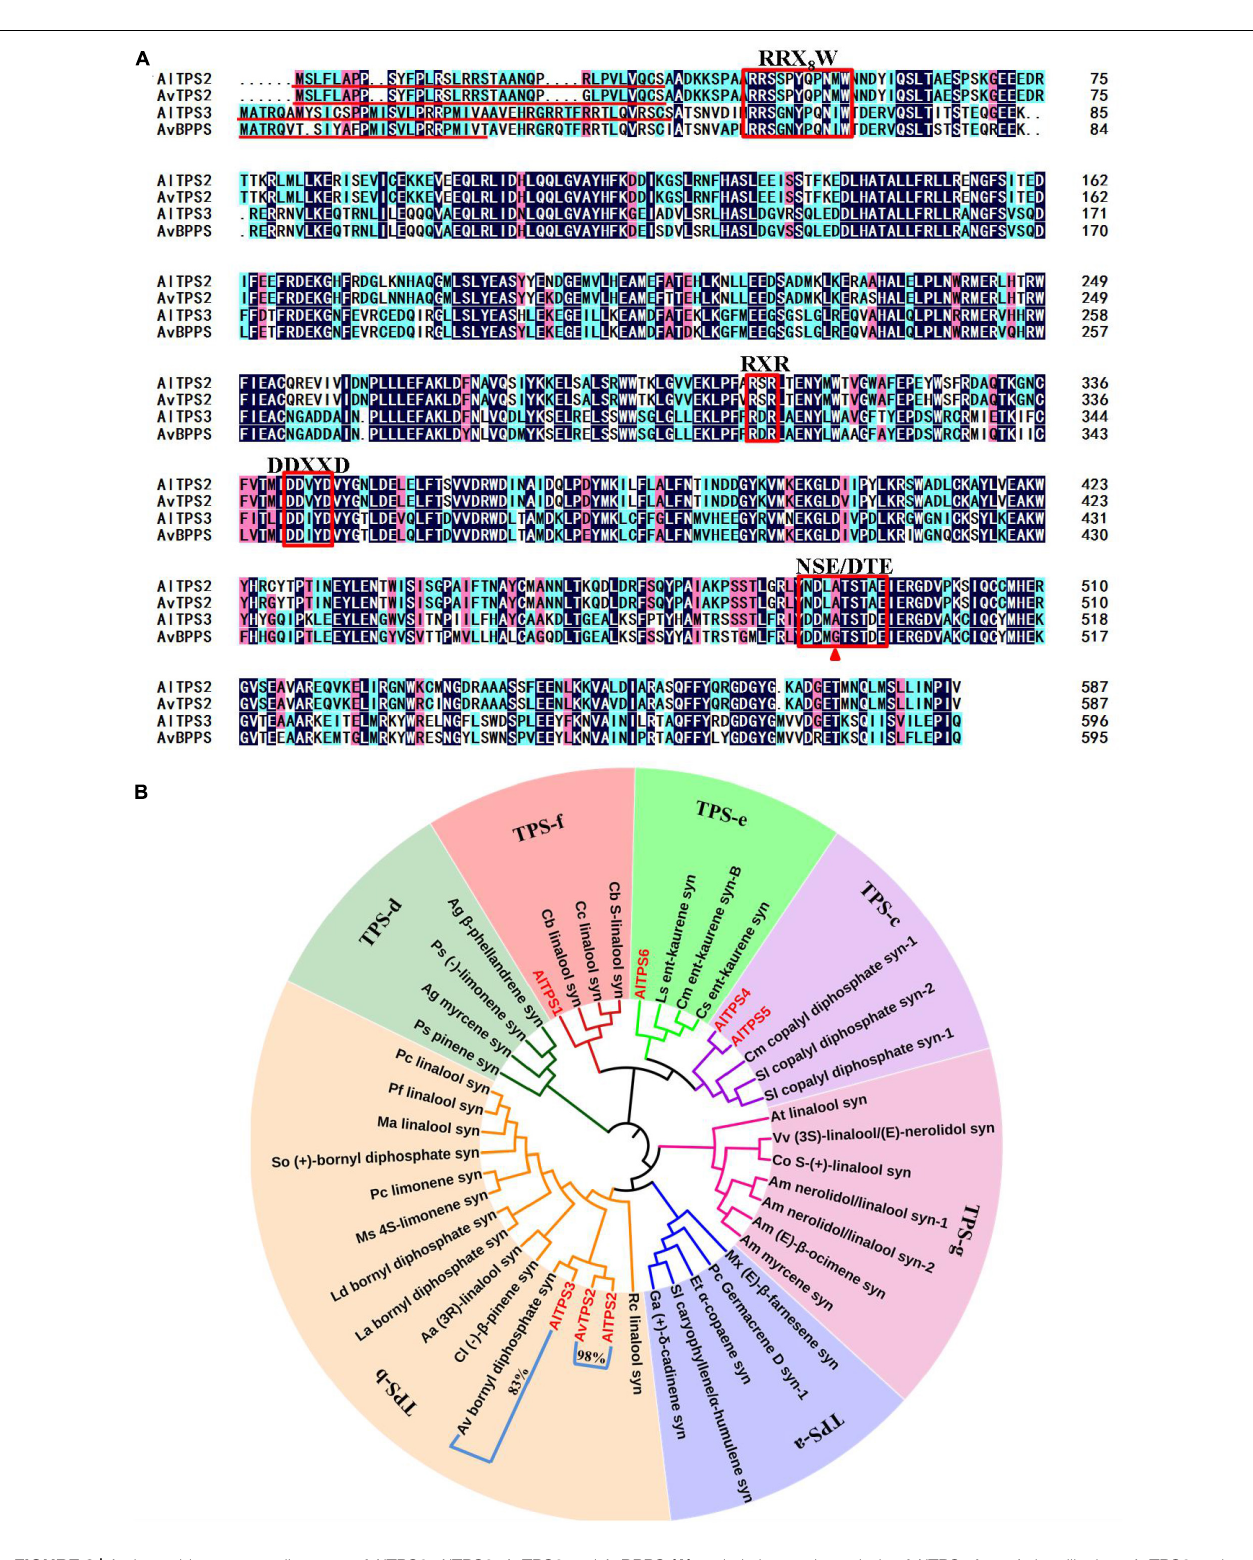
Frontiers in Plant Science |